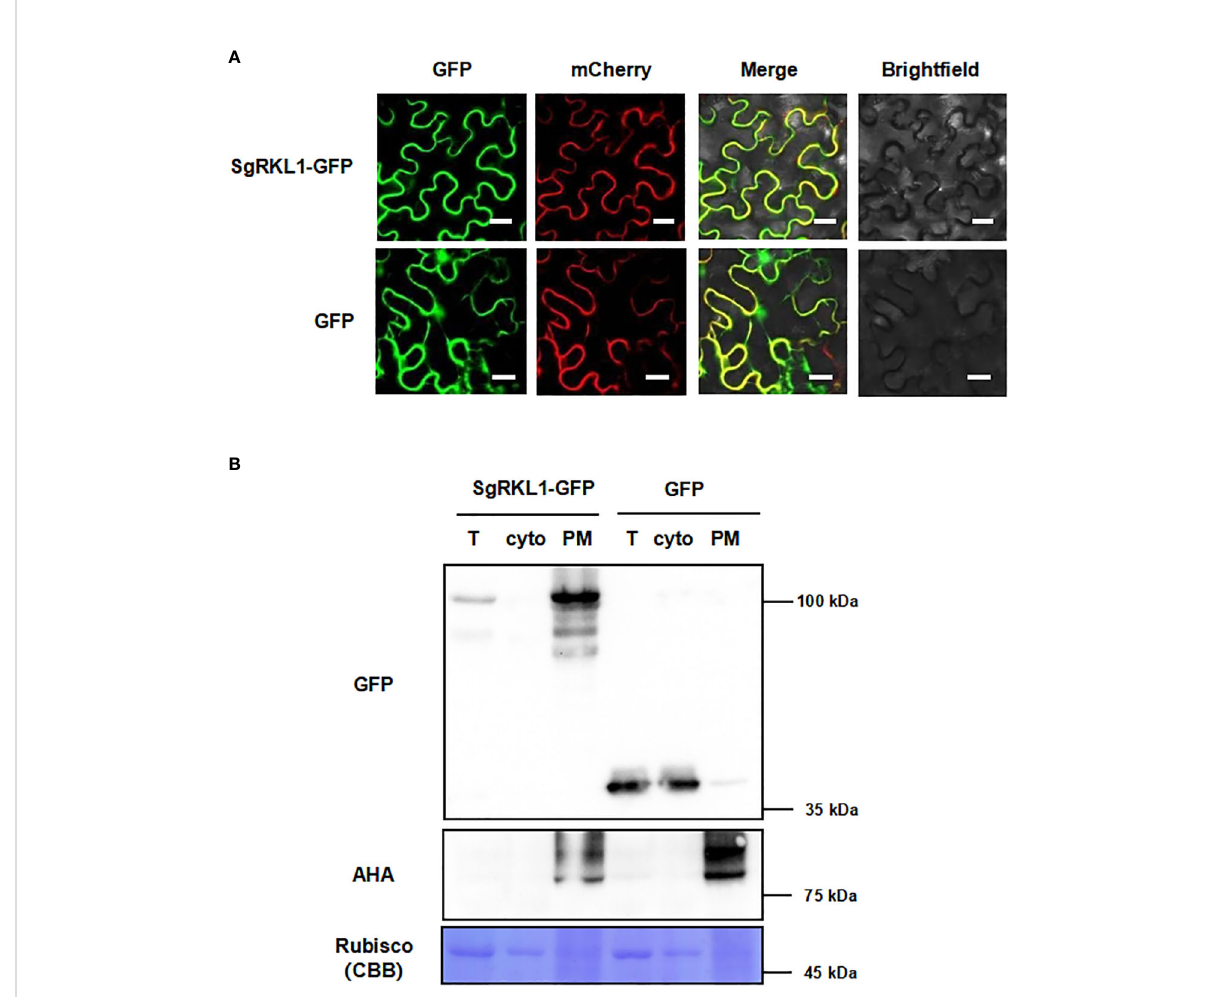
FIGURE 8 Subcellular localization of the identi fi ed PM protein SgRKL1. (A) Co-localization of SgRKL1-GFP and PM marker protein PIP2A-mCherry. Images were taken using confocal microscopy 2 days after in fi ltration in N. benthamiana . Bars, 20 µM. (B) Immunoblot analysis of SgRKL1-GFP transiently expressed in N. benthamiana . Total protein (T), cytosolic fraction (cyto), plasma membrane enriched fraction (PM) were collected 2 days after in fi ltration. Immunoblot analysis was performed using anti-GFP and anti-AHA antibodies to detect the distribution of SgRKL1-GFP/free GFP and PM marker protein AHA, respectively. Coomassie blue staining CBB was performed to show the distribution of Rubisco protein. The experiments were repeated three times with similar results as